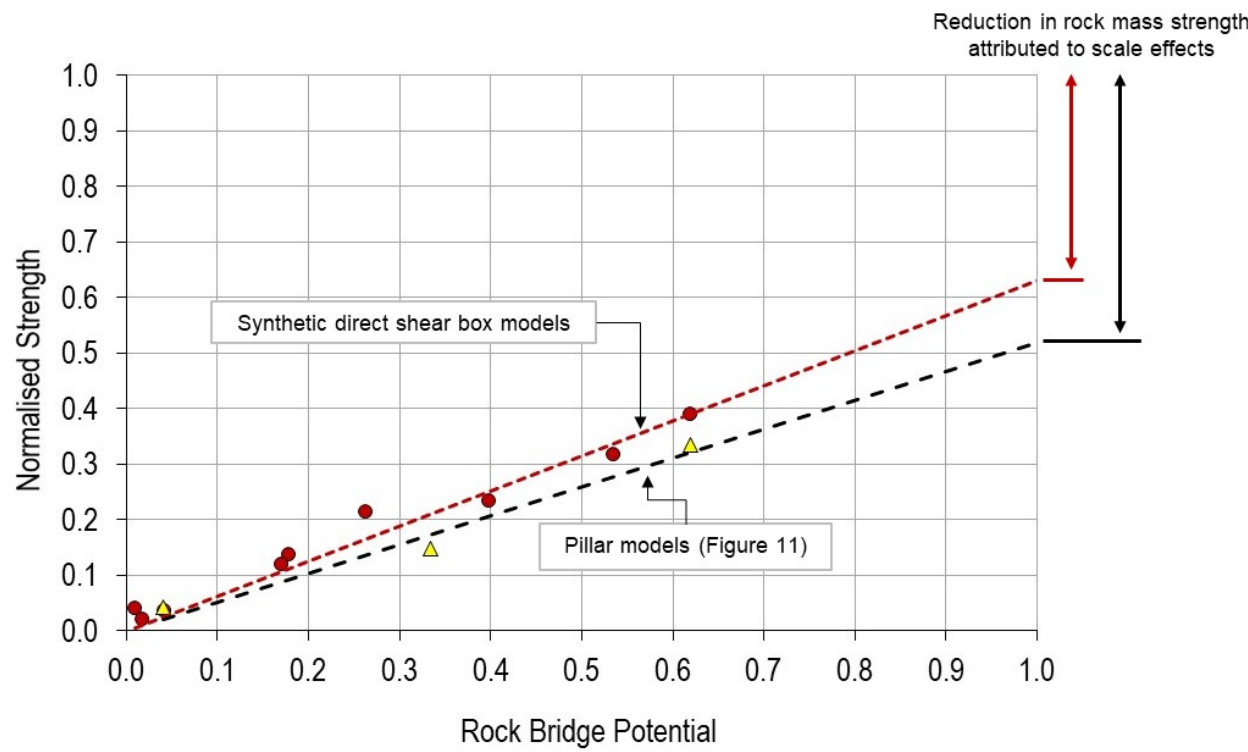
Figure 13. Comparison between the normalised strength calculated using the concept of rock bridge percentage and the normalized strength corresponding to the modelled value of rock bridge poten ‐ tial. The results show the critical problem with the rock bridge percentage approach and the risk of using non ‐ conservative assumptions when adopting the method proposed by [3,5,6].